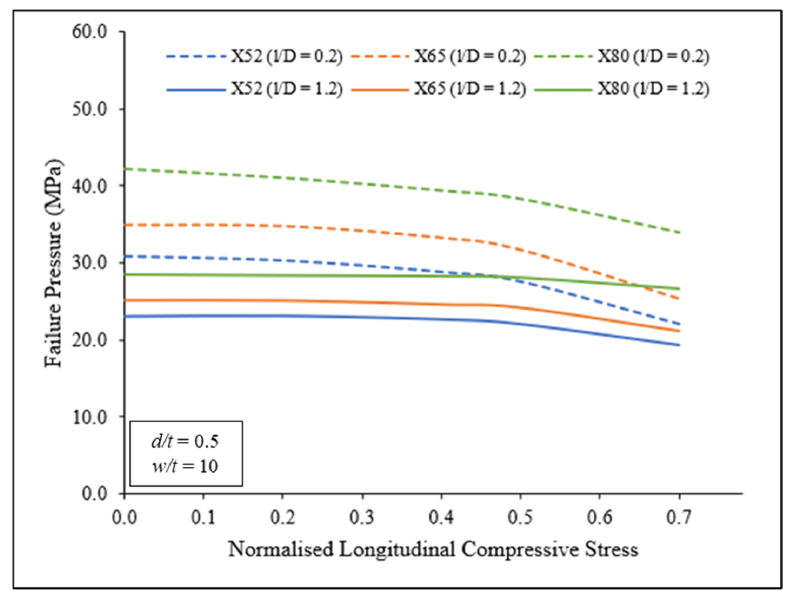
Figure 12. Failure pressure against normalised longitudinal compressive stress with 0.2 and 1.2 normalised defect lengths for X52, X65, and X80.